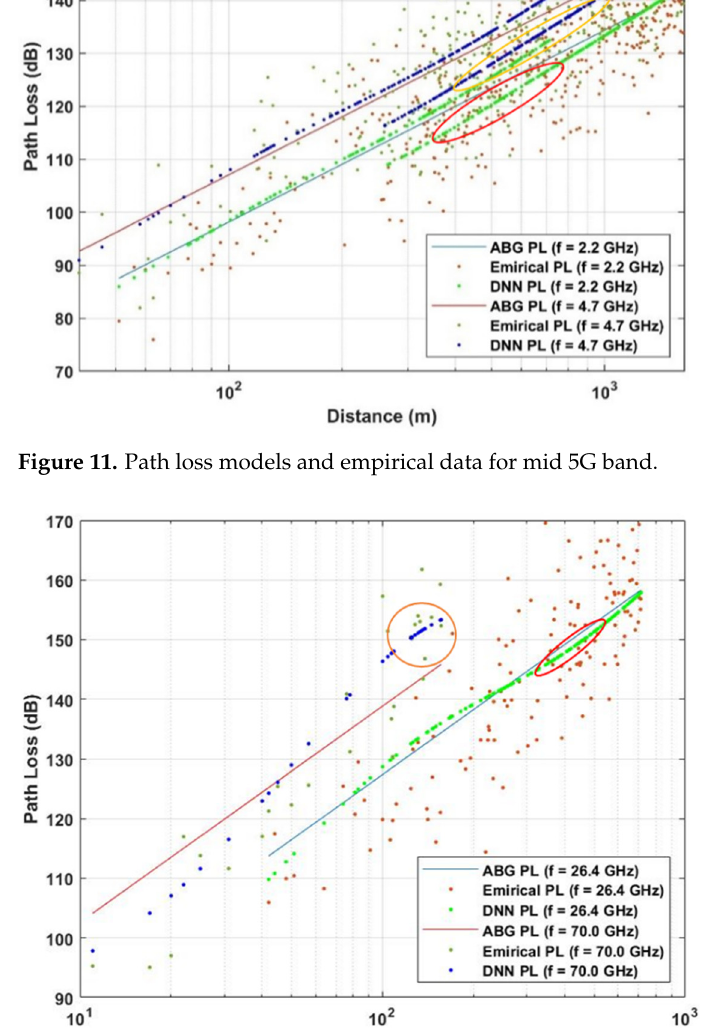
Figure 12. Path loss models and empirical data for high 5G band.